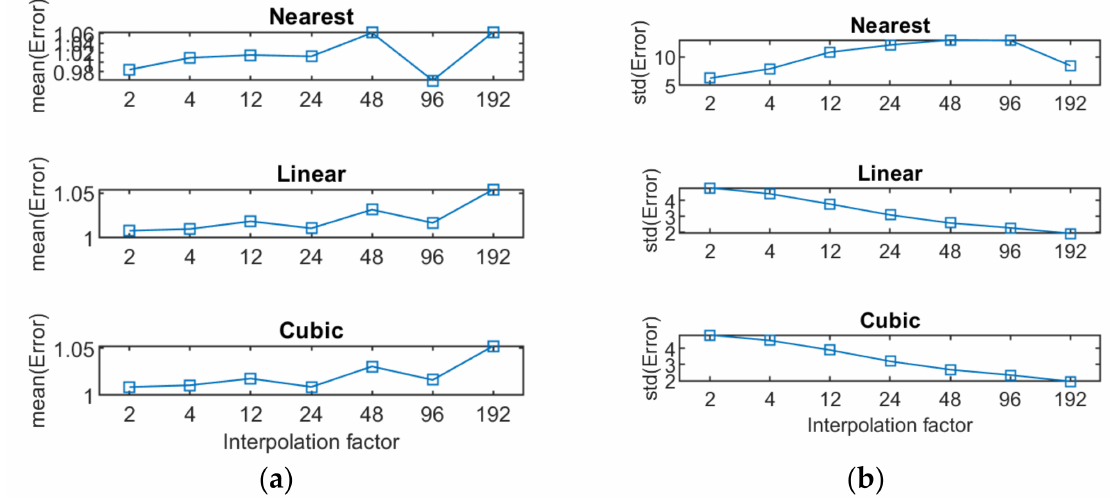
Figure 14. Mean error ( a ) and error standard deviation ( b ) describing the difference between the normalized temperature in R1 and the arc